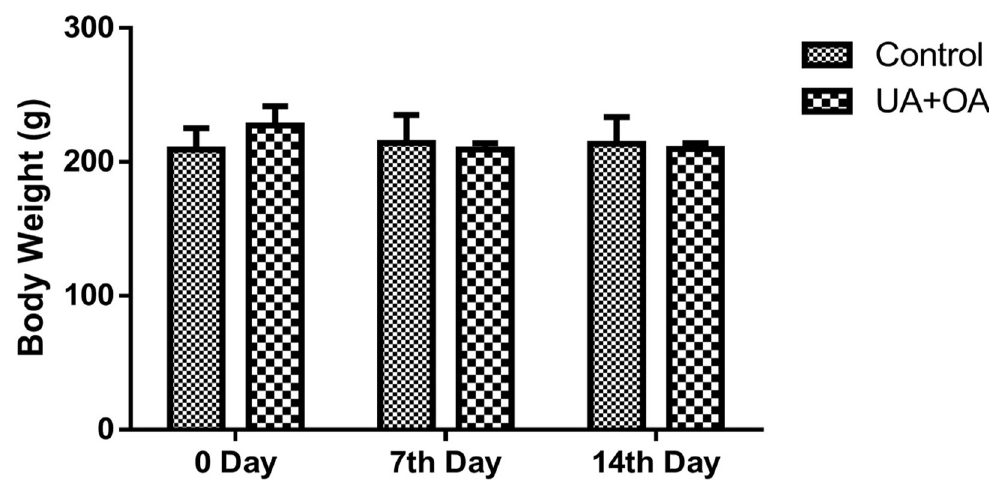
Table 2. Changes in organ weight of female rats of the control group in an acute toxicity. Organ